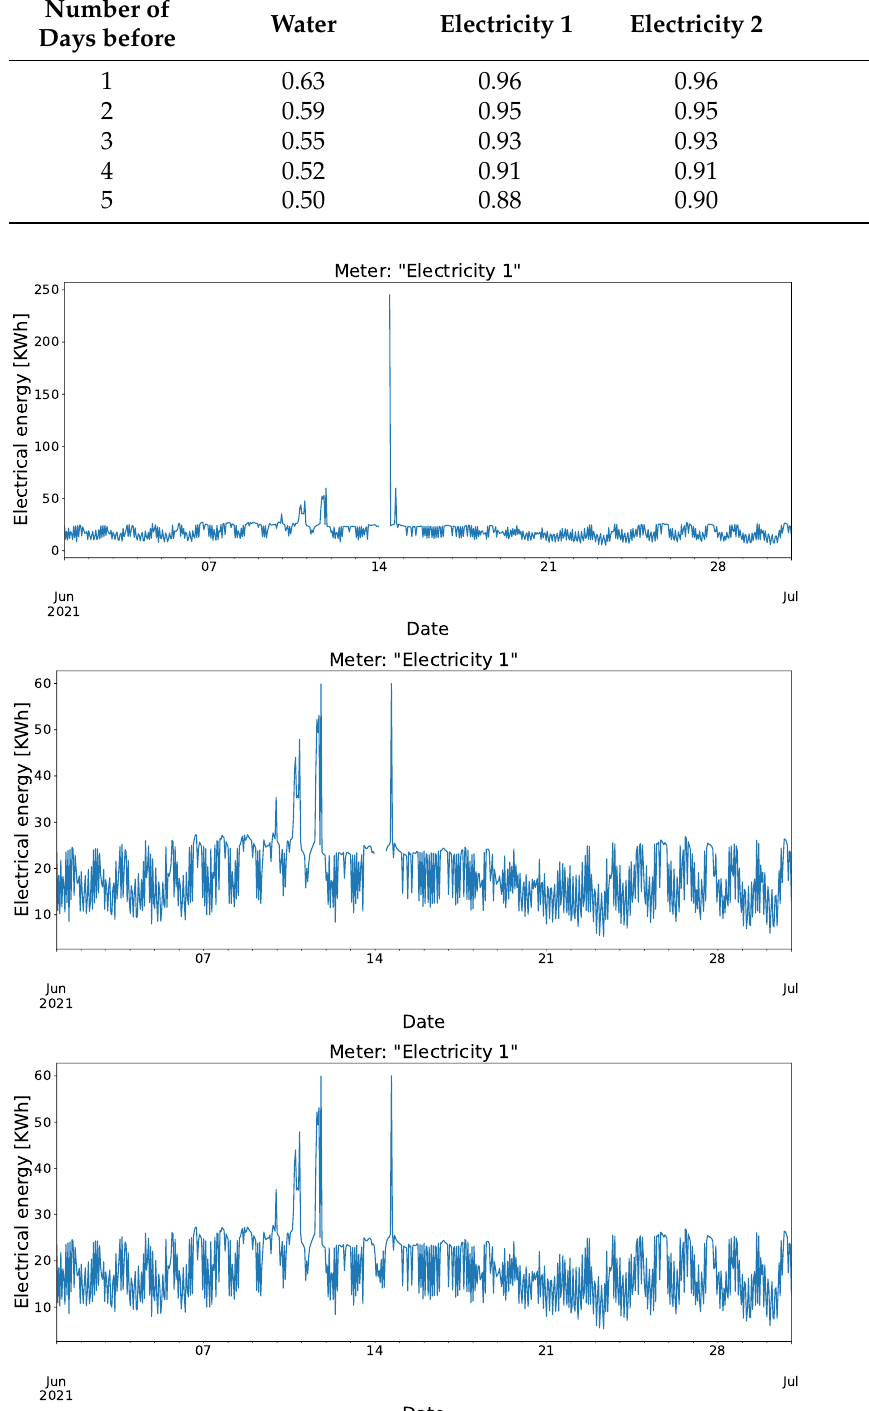
Table 3. Values of existing correlations between readings at 12:00 P.M. (midnight) and readings that occurred at the same time on previous days.